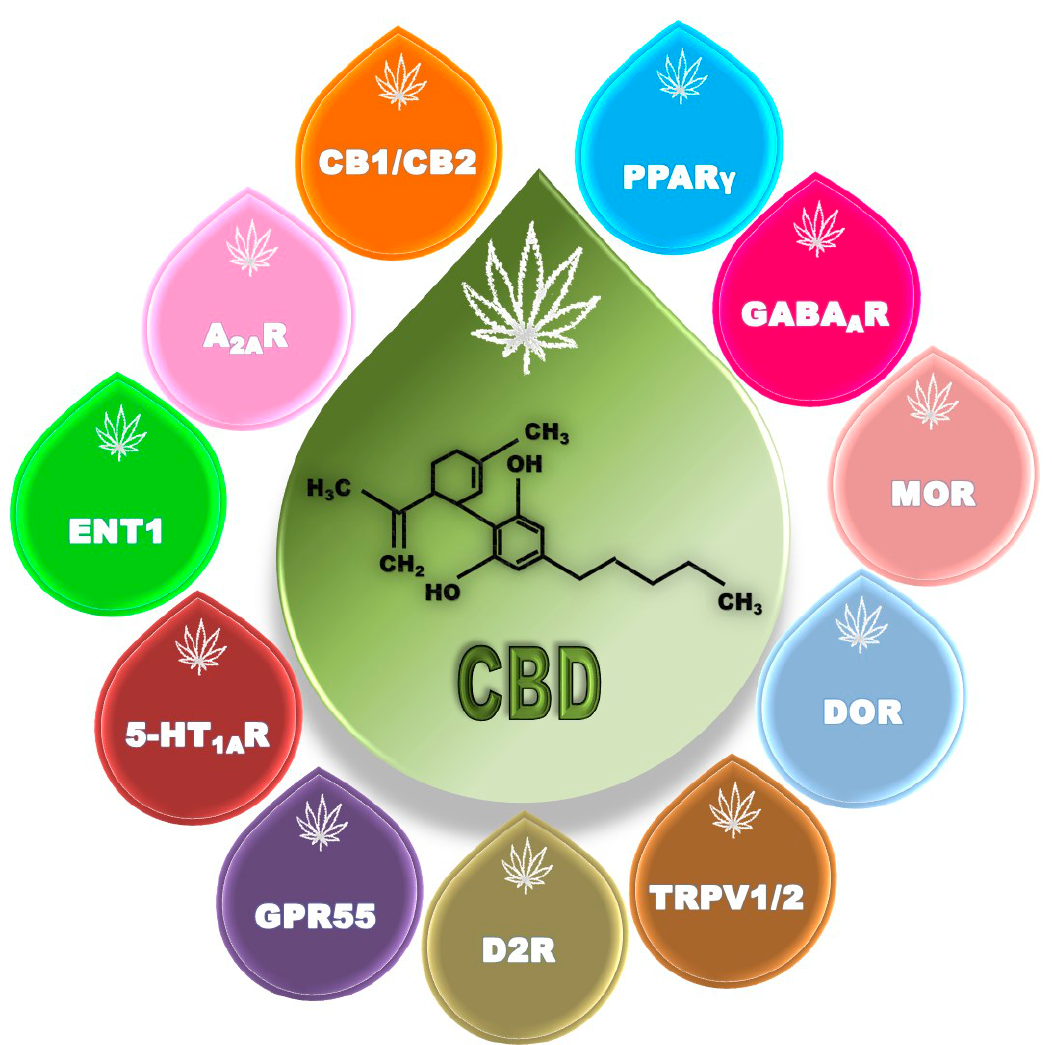
Figure 1. Some molecular targets of CBD’s actions in the brain. CBD acts as a negative allosteric modulator of CB1, MOR, and DOR receptors; as an inverse agonist of CB2 receptors; as an agonist of A 2A , 5-HT 1A , D2, PPAR ү , TRPV1, TRPV2, and GABA A receptors; as an antagonist of GPR55 receptor; and as an inhibitor of ENT1. CBD, cannabidiol; CB1, cannabinoid receptor type 1; CB2, cannabinoid receptor type 2; A 2A R, adenosine receptor 2A; ENT1, equilibrative nucleoside transporter 1; 5-HT 1A R, serotonin receptor 1A; D2, D2-like dopamine receptor; GPR55, G-protein-coupled receptor 55; PPAR γ , peroxisome proliferator-activated receptor gamma; GABA A R, gamma-aminobutyric acid receptor A; MOR, mu opioid receptor; DOR, delta opioid receptor; TRPV1, transient receptor potential vanilloid type 1; TRPV2, transient receptor potential vanilloid type 2.